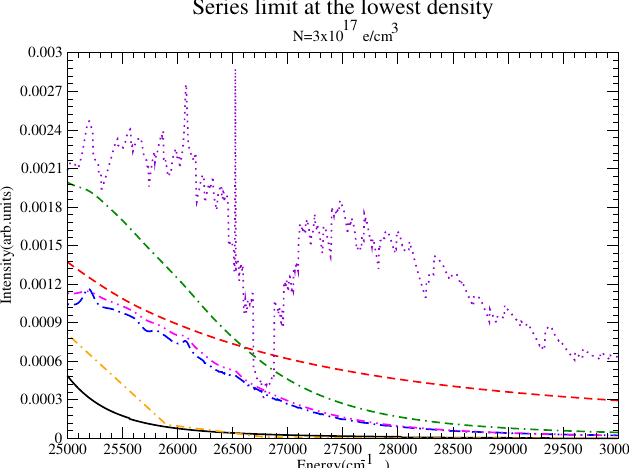
Figure 12. Comparision of line widths. Shown are QC-FFM (solid), PPP (dashed), DWE (dash-dotted), CONVST without strong collisions (dotted), CONVST with strong collisions (dot-double dashed), CONVPST without strong collisions (long dash-dotted) and CONVPST with strong collisions (dash-double dotted).